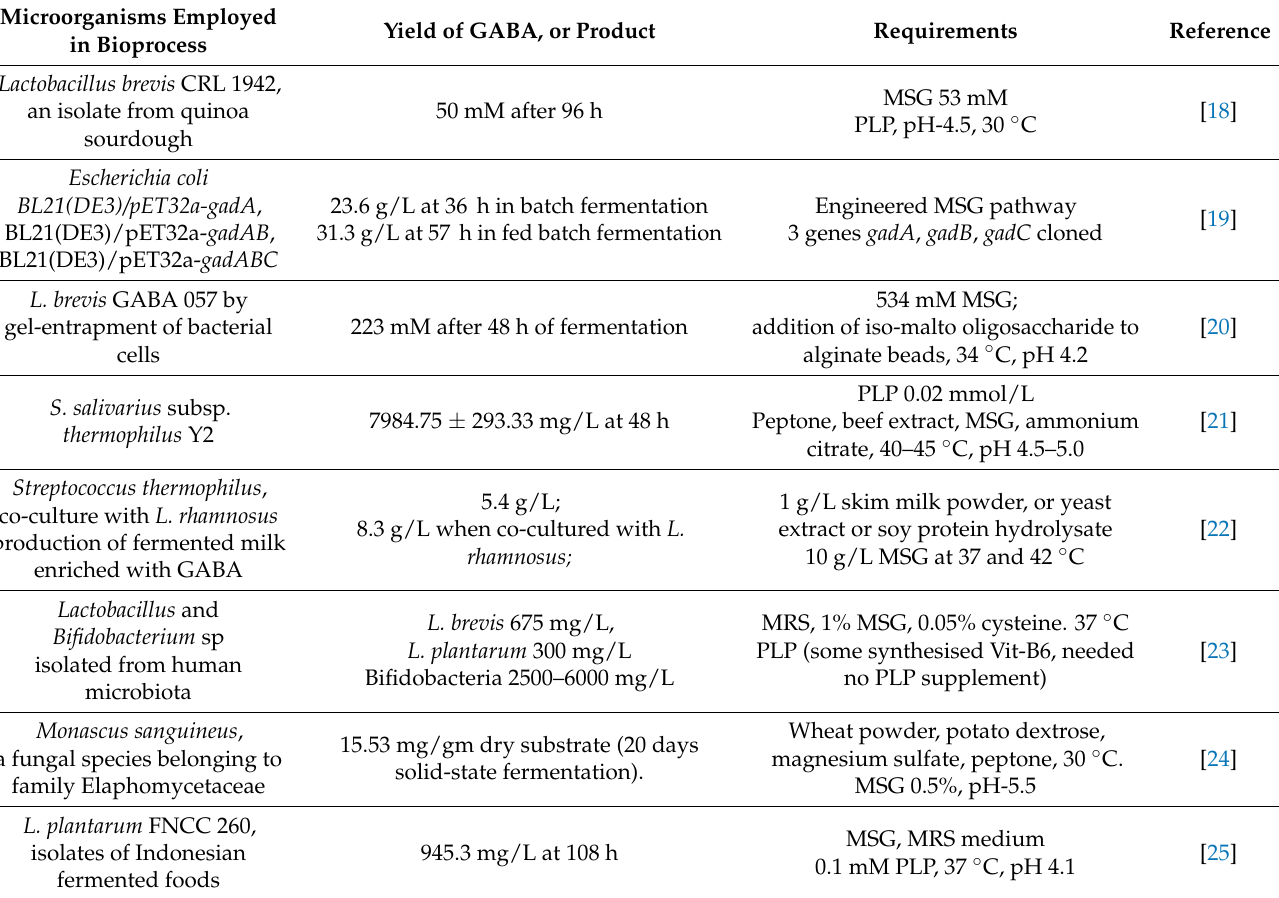
Table 2. Selected Microbial Systems and Their Requirements for the Synthesis of GABA. Microorganisms Employed in